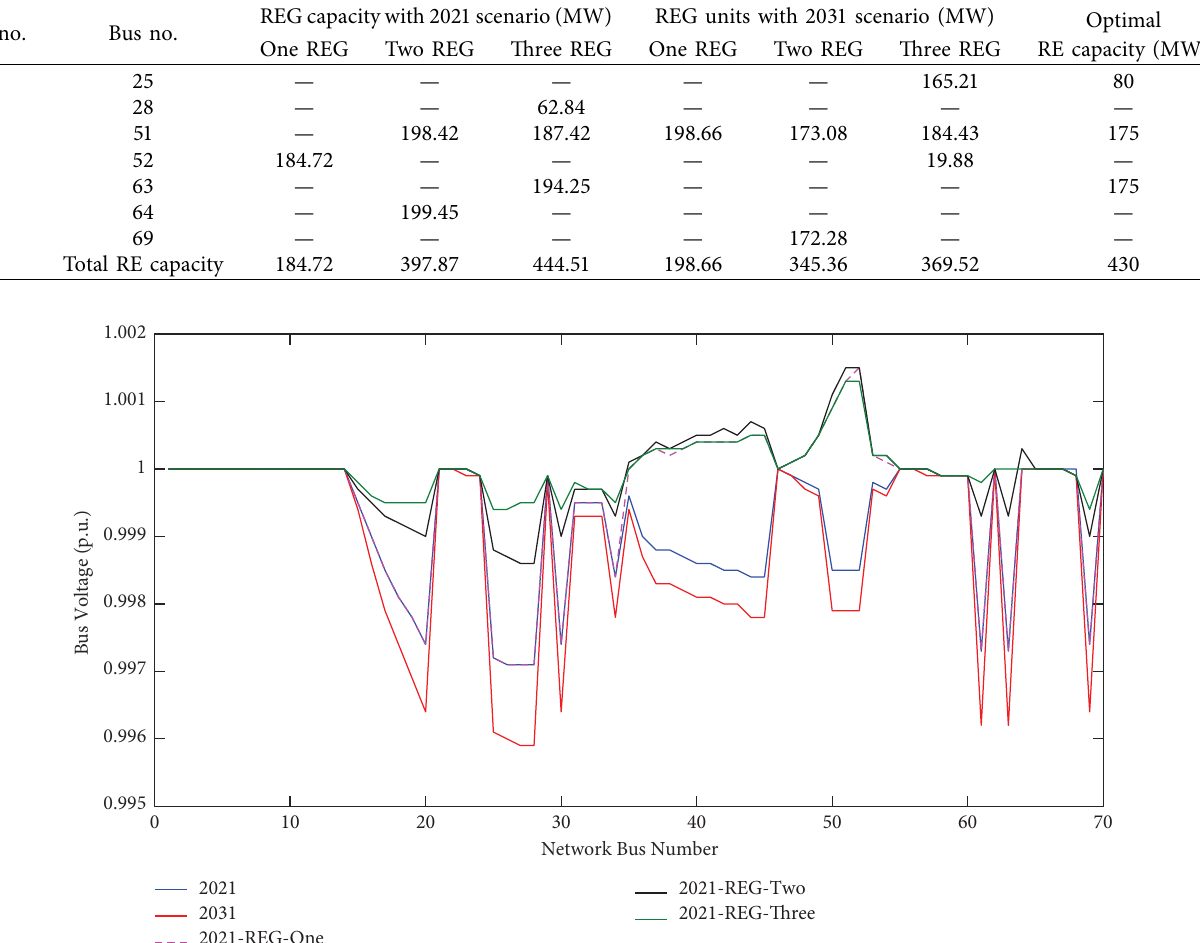
Figure 9: Voltage profle of network buses for the scenario of base year